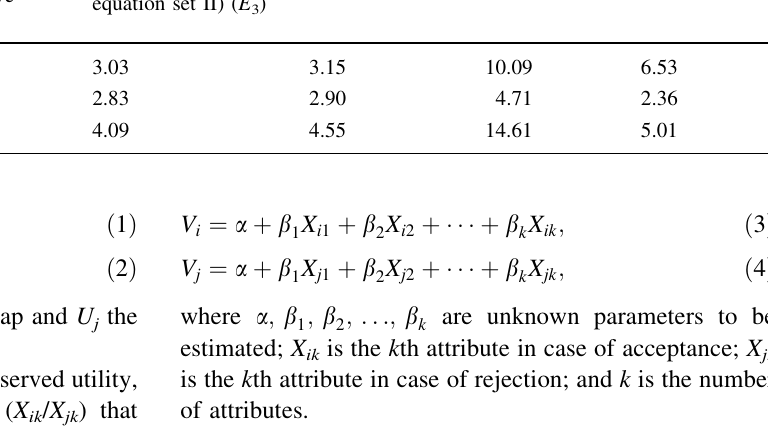
Table 9 Estimation of critical gap (s) by various approaches Intersection Logit model considering aggressive behavior (using equation set I)